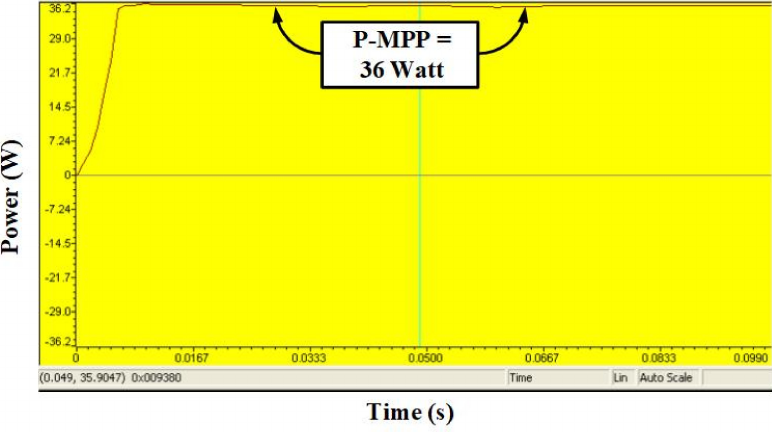
Figure 21. PV power for FLC at partial shading